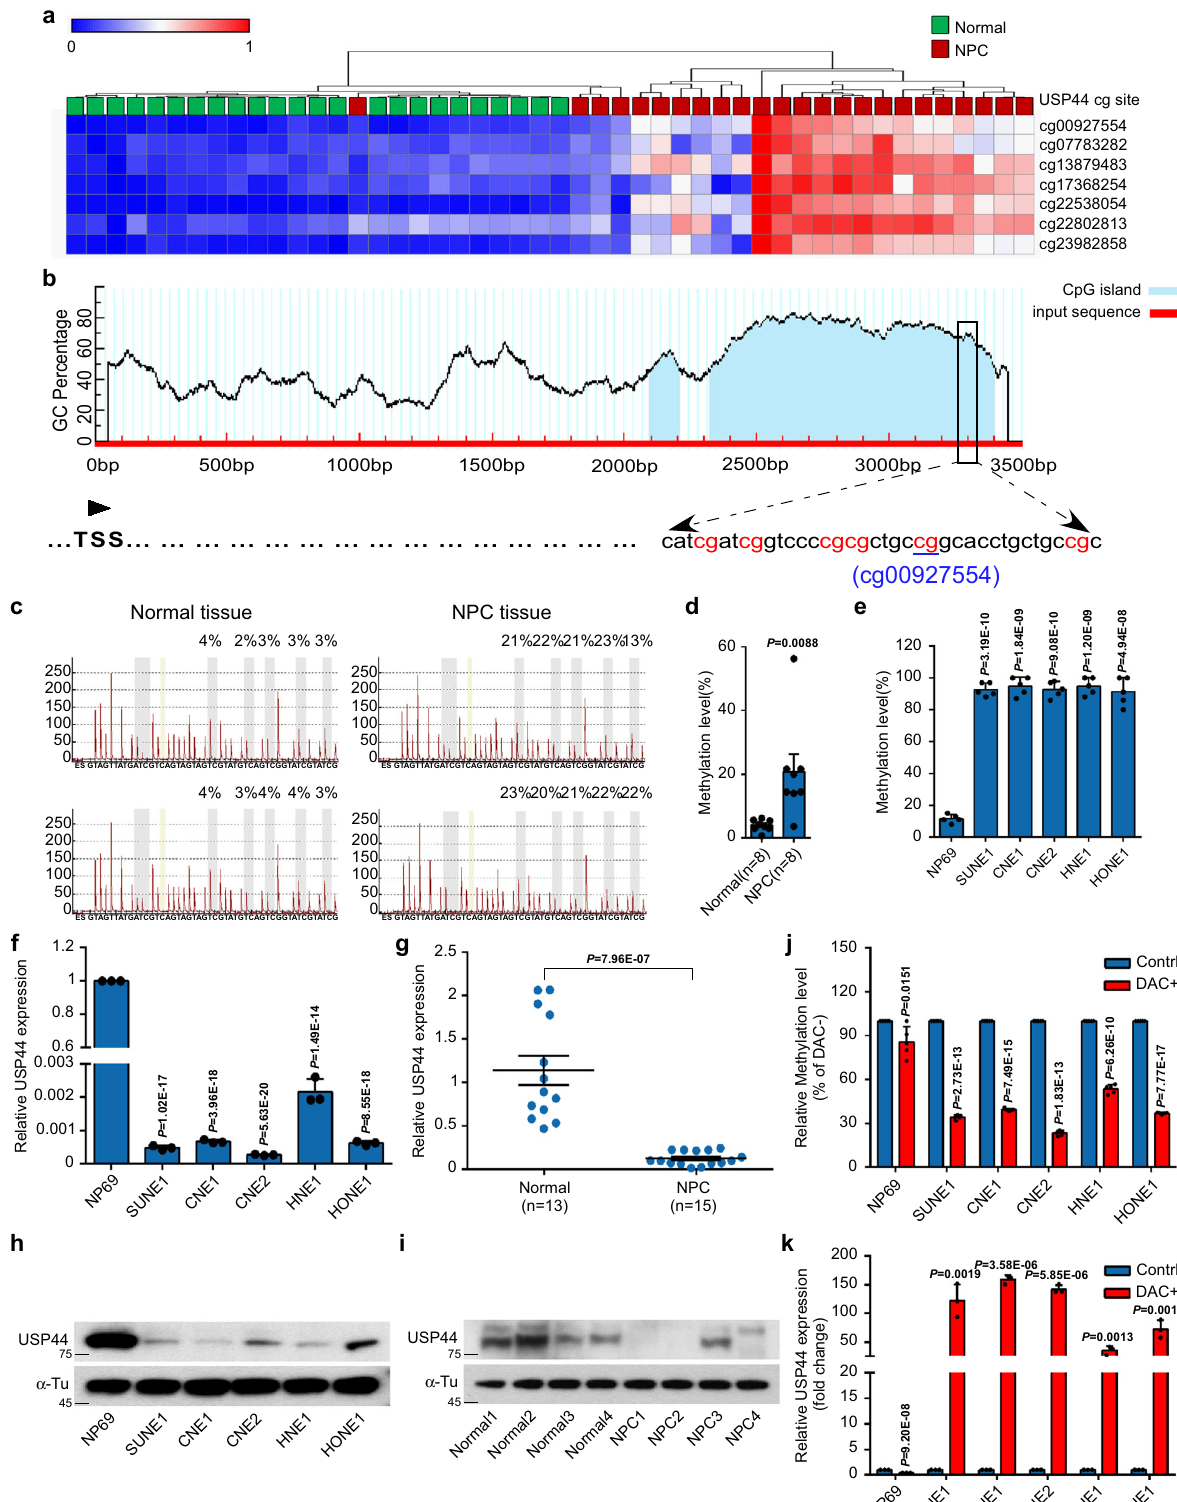
sought to determine how the interaction between USP44 and Ku80 proteins affects radiosensitization in NPC. We found that overexpression of USP44 decreased the protein expression level of Ku80 in a dose-dependent manner but did not affect its mRNA expression level (Fig. 3d and Supplementary Fig. 4b). Over- expression of USP44 signi fi cantly promoted the degradation